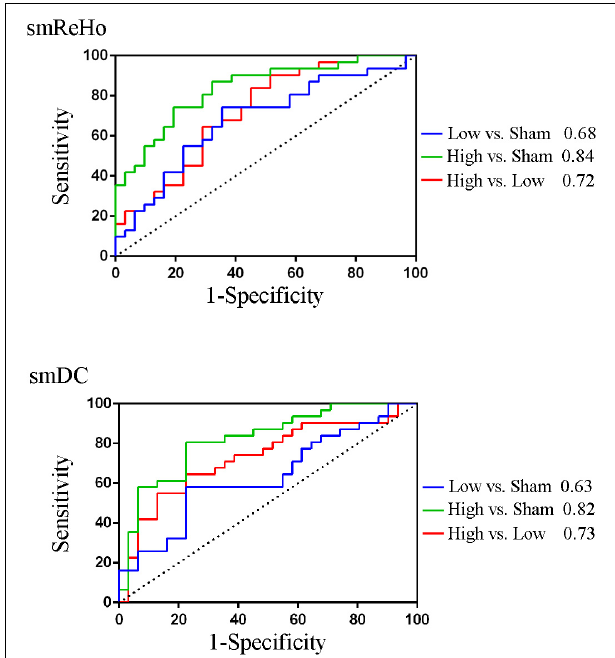
FIGURE 7 | The area under the curve (AUC) of the receiver operating characteristic (ROC) of the peak voxels of the F maps of ReHo ( x = 39, y = -60, z = -54) and DC ( x = 42, y = -57, z =